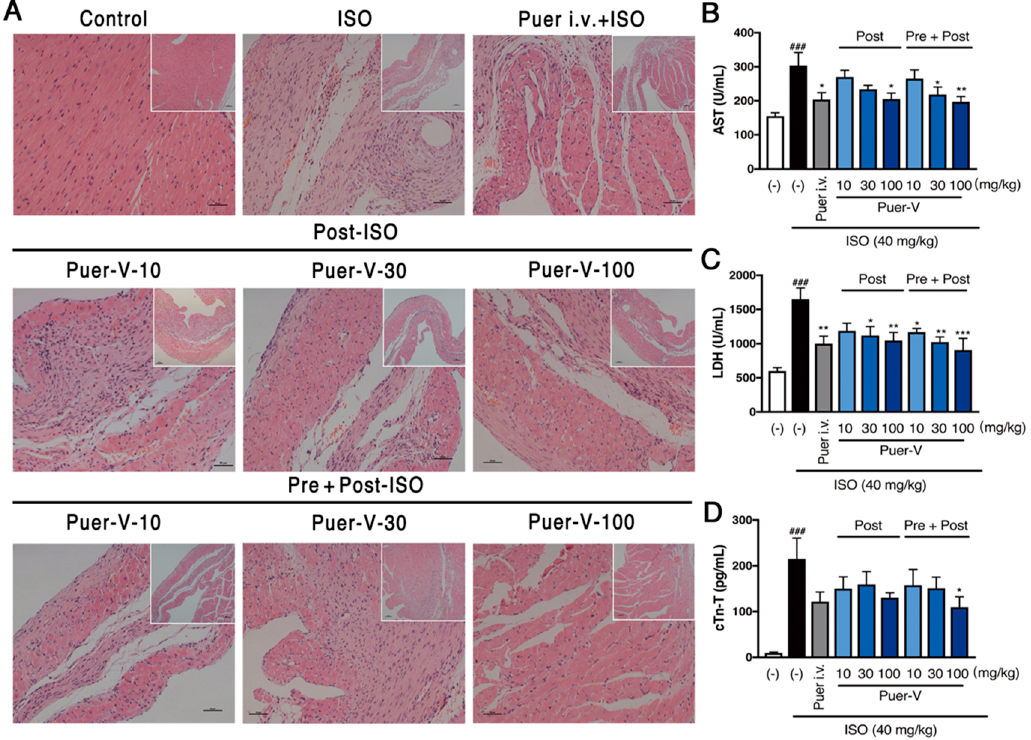
Figure 3. Puerarin-V treatment suppressed myocardial inflammation and reduced myocardial cell damage in the MI mice. ( A ) Representative images of H&E staining of right ventricular cardiomyocytes in different groups. Small images were 100 × , and the big images were 200 × . Scale bar = 100 µ m. ( B – D ) The serum levels of AST, LDH and cTn-T. Data are shown as mean ± SEM ( n = 6). ### p < 0.001 vs. control group. * p < 0.05, ** p < 0.01, and *** p < 0.001 vs. model group.